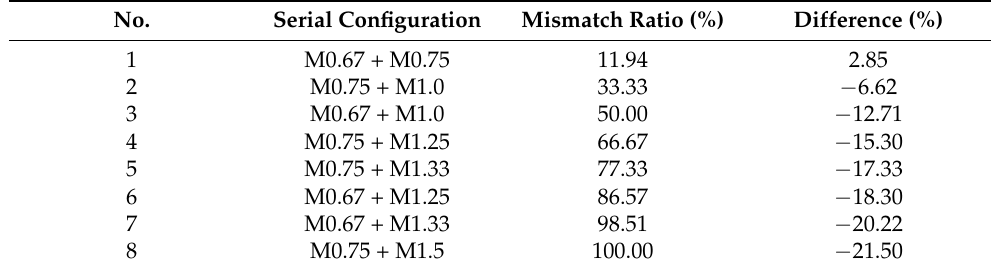
Table 10. The difference between the estimated and the experimental values of